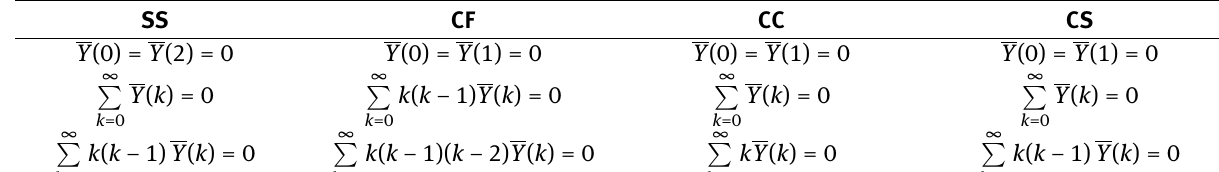
Table 2: Differential Transformation for SS, CF, CC and CS boundary condition